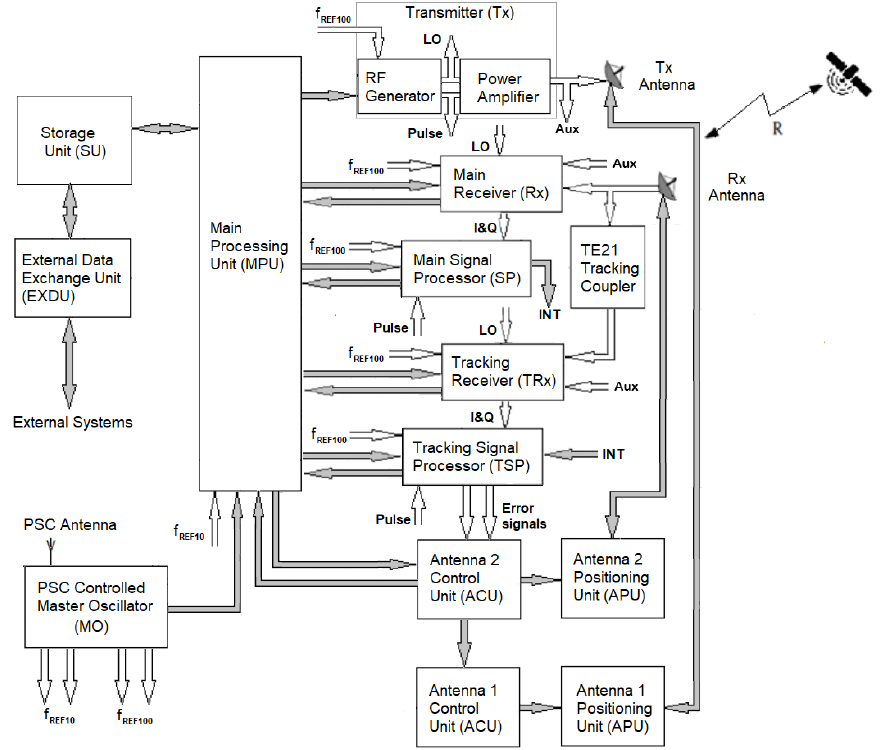
Figure 5. General diagram of Cheia SST radar.